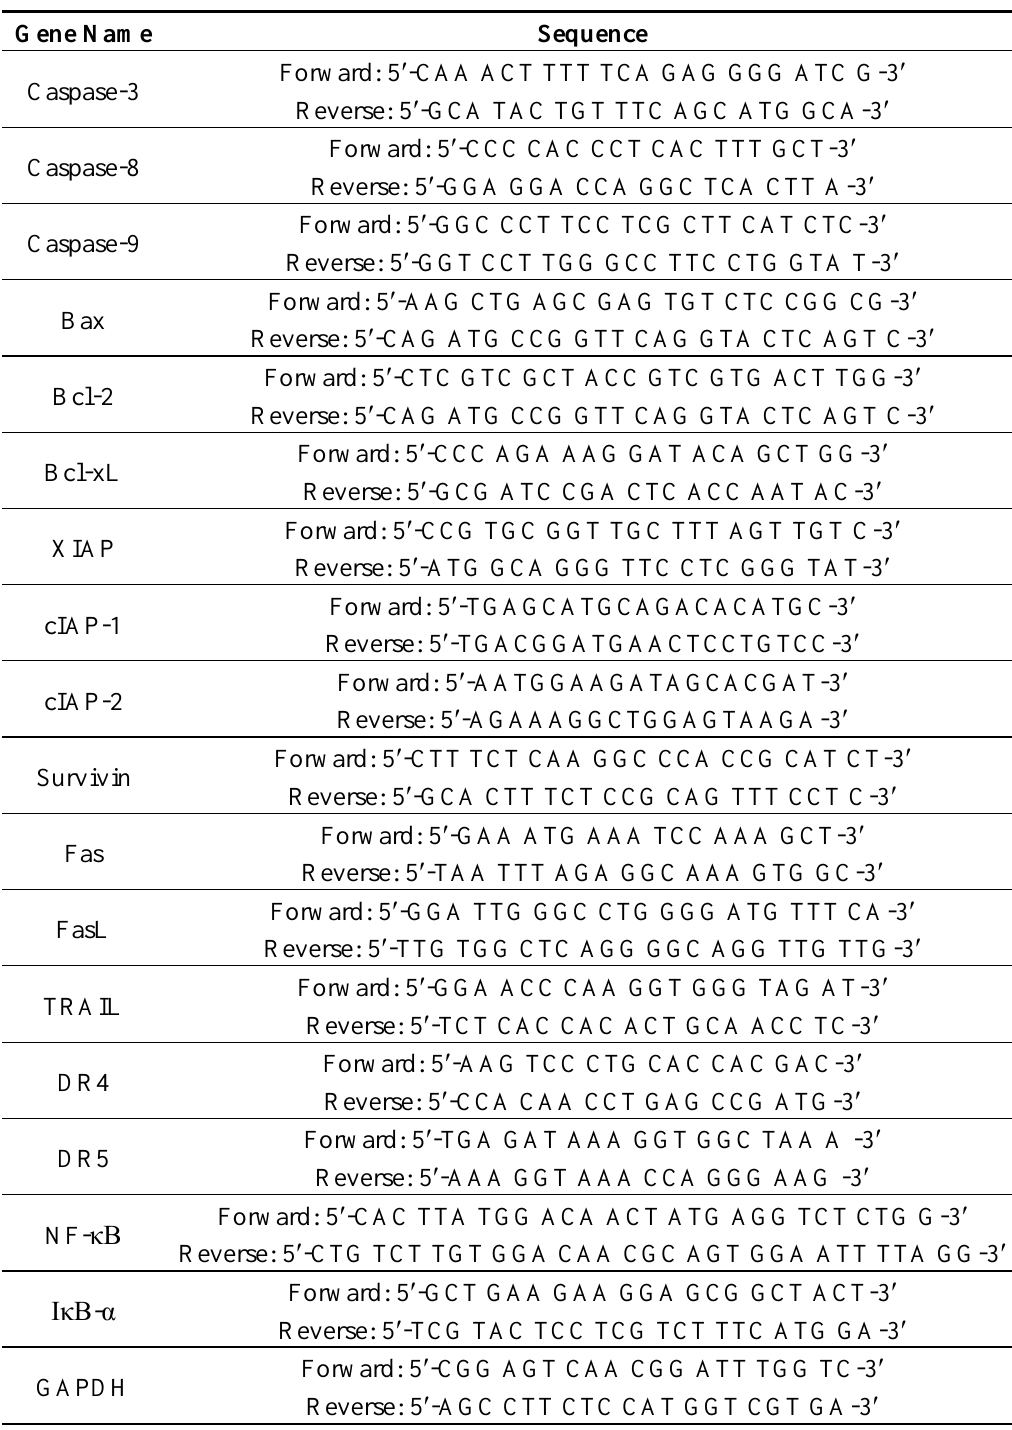
Table 1. Sequences of reverse transcription-polymerase chain reaction primers were used in this